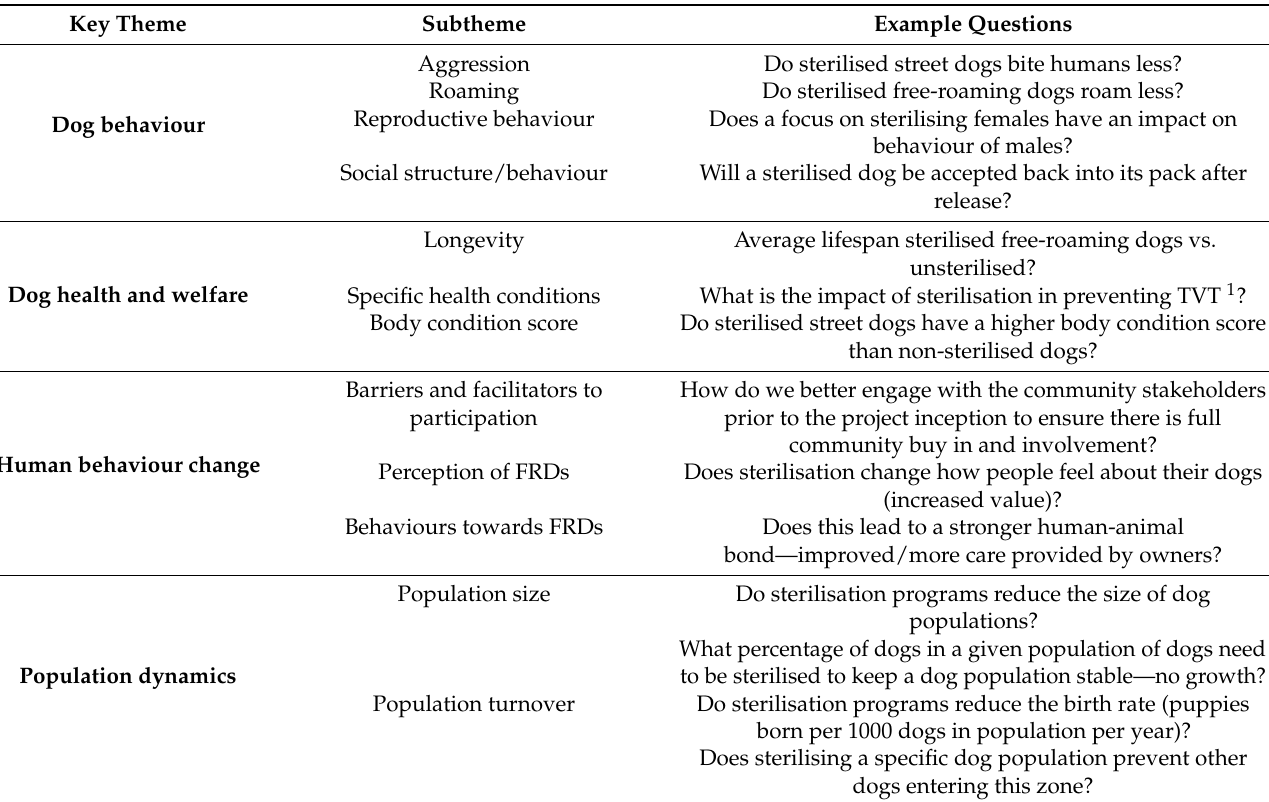
Table 2. Key themes and subthemes generated from submitted